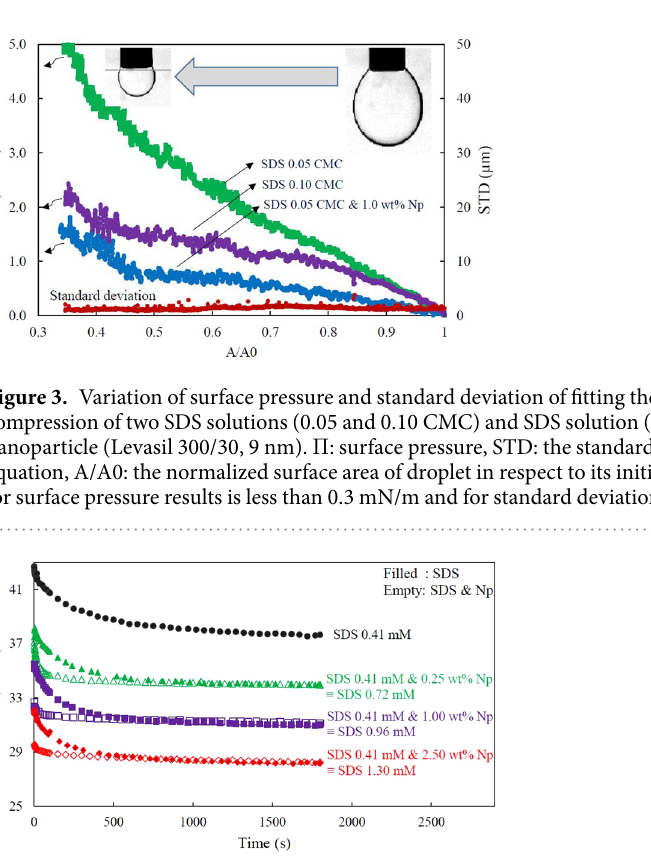
Figure 4. Estimation of the equivalent surfactant concentration (EC) of mixed surfactant-particle solutions by matching their equilibrium IFTs with those of surfactant-only